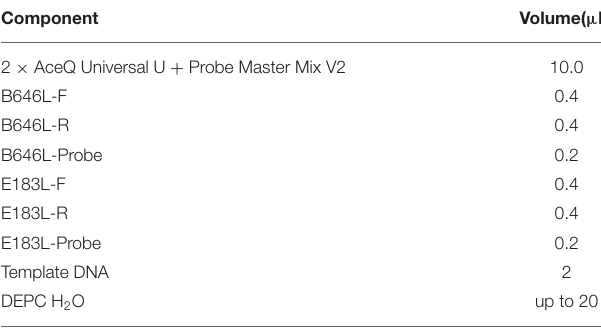
TABLE 2 | The amplification reaction